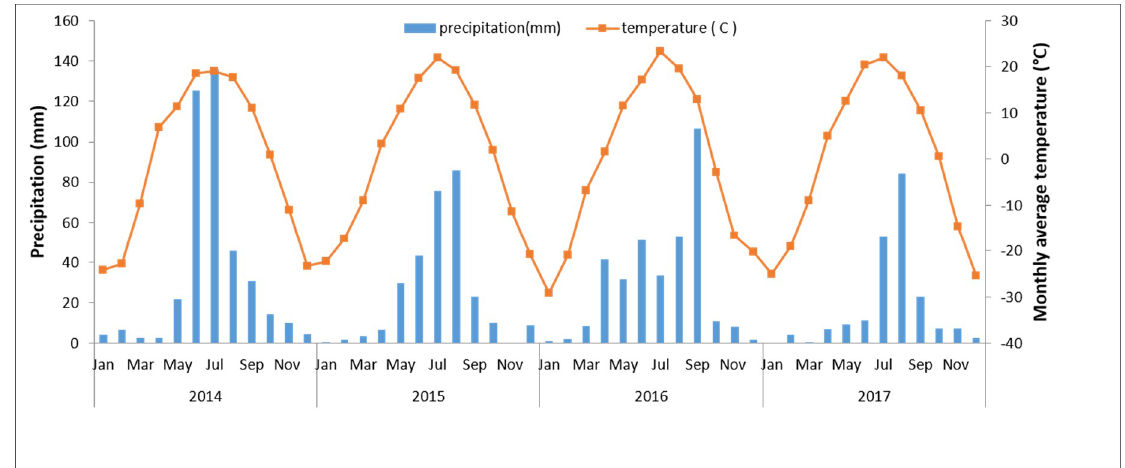
Figure 1. Monthly average temperature and precipitation over selected periods at the experimental site in the meadow steppe of Hulunbuir, Inner Mongolia. Left y‐axis—annual mean precipitation and right y‐axis—annual mean temperature from 2014 to 2017. Season 2014 was the highest precipitation.